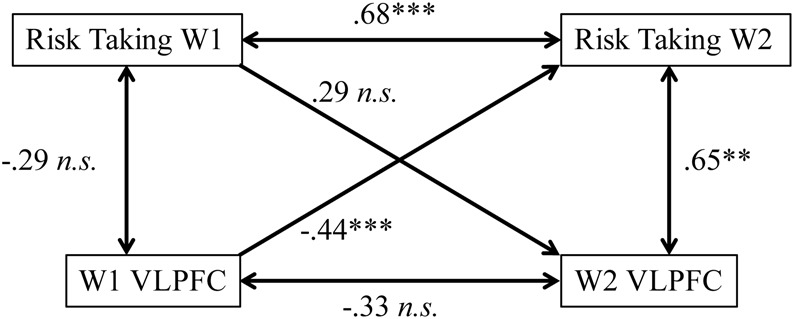
Correlations between variables at W1 and W2. While W1 VLPFC activity predicts W2 risk taking controlling for W1 risk taking, the reciprocal path of W1 Risk Taking to W2 VLFPC activation controlling for W1 activity is not significant. Zero-order correlations are indicated with double-headed arrows, while regression analyses controlling for both W1 variables are indicated with single-headed arrows. ∗∗p < 0.005, ∗∗∗p < 0.0001.